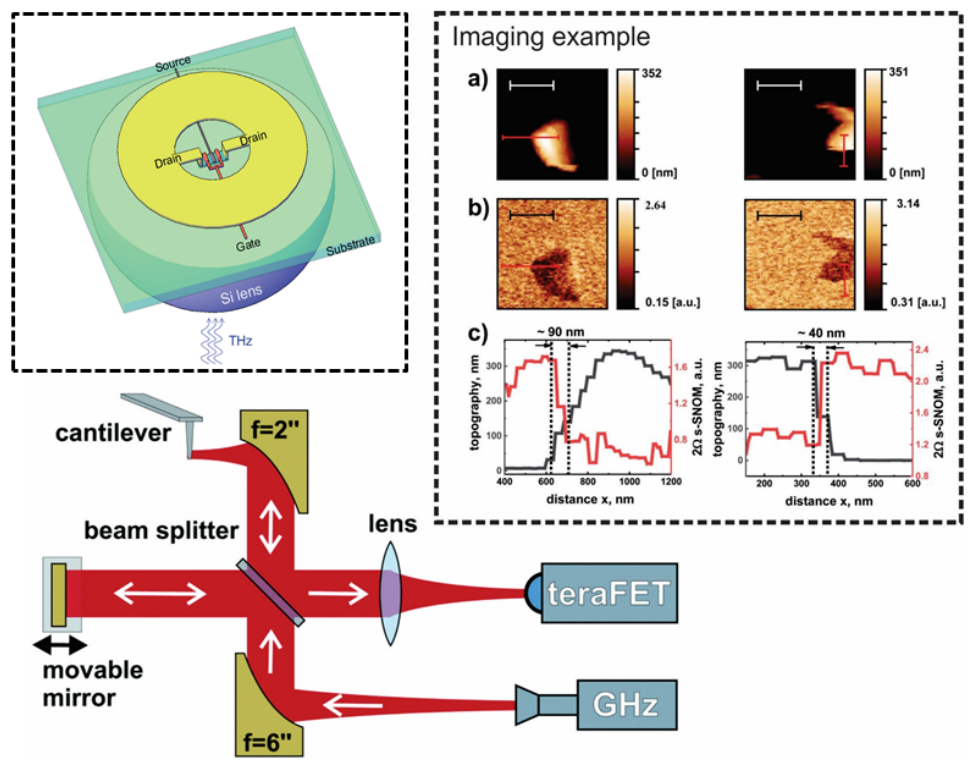
Figure 6. Schematic of an all-electronic homodyne s-SNOM measurement setup with a detector based on a Si CMOS field-effect transistor. Left inset: 3D layout of the detector with the monolithically integrated annular ring antenna and the Si substrate lens. Active devices were fabricated using either a 90 nm or a 180 nm technology process node. The high sensitivity enables demodulation of the s-SNOM signal at up to the 10th harmonic of the cantilever’s oscillation frequency. Right inset: ( a ) AFM topography of a Si surface (black) with dielectric islands (brown); ( b ) simultaneously measured s-SNOM amplitude images recorded at the 2nd harmonic of the cantilever’s oscillation frequency. Scale bars in ( a , b ): 1 µ m. ( c ) Line scans along the red lines in ( b ) showing a spatial resolution down to <50 nm. Figure modified from Ref.